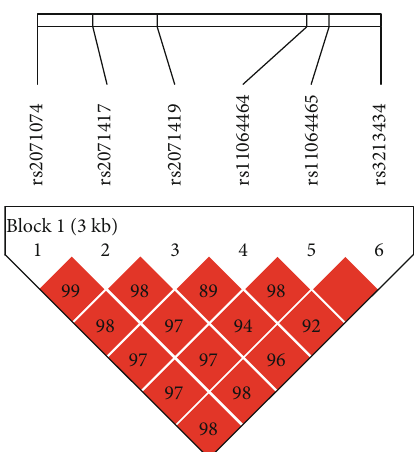
Figure 1: Haplotype block structure of ACMP and DEACMP patients. The index association SNP is represented as a diamond. The color of the remaining SNPs (circles) represents LD, and the indexed SNPs are based on the paired r 2 values in our